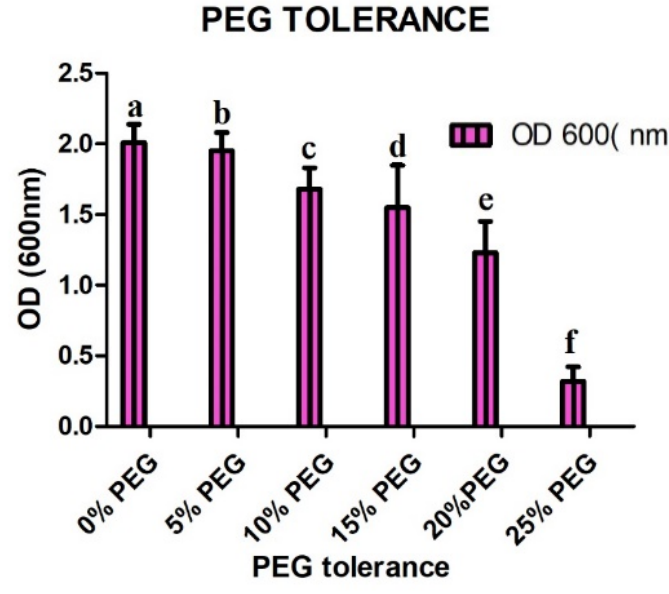
Figure 3. Growth of SH-6 under different concentrations of PEG 6000. The latter on each bar is the significant different between treatment at p ≤ 0.5, where ND = not detected. The error bar represents the standard error among the replicates.